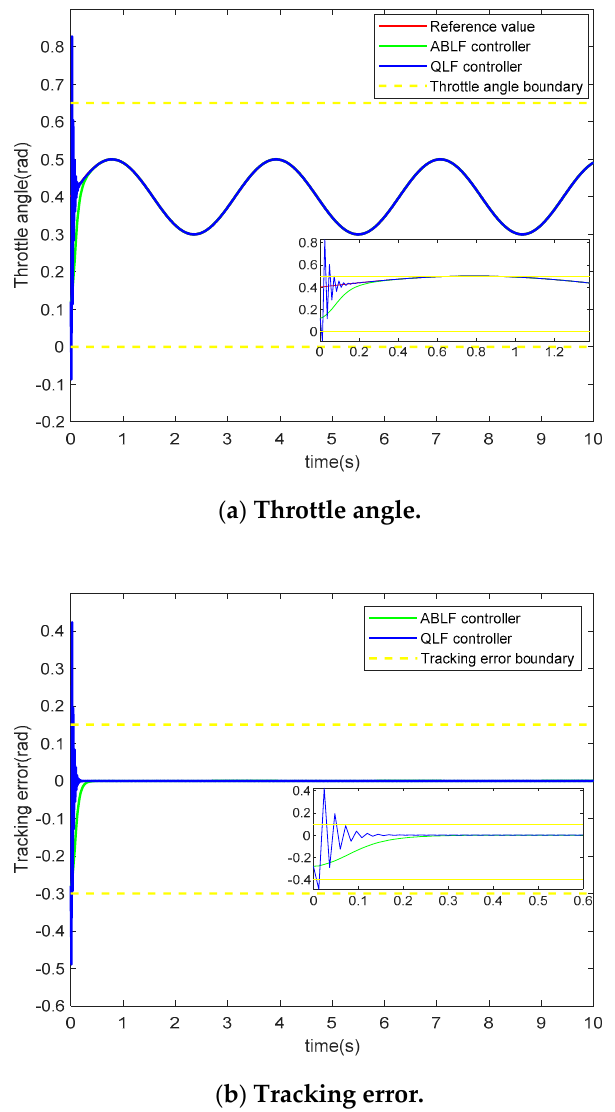
Figure 5. Simulation results under sinusoidal signal: ( a ) Throttle angle, ( b ) Tracking error.